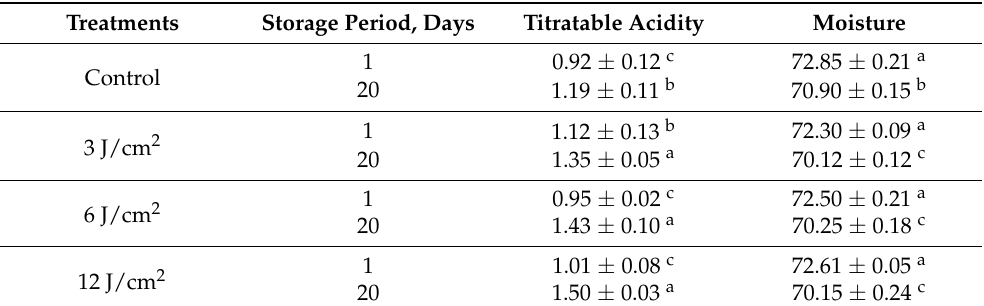
Changes in the titratable acidity (% lactic acid) and moisture levels of different labneh treatments.